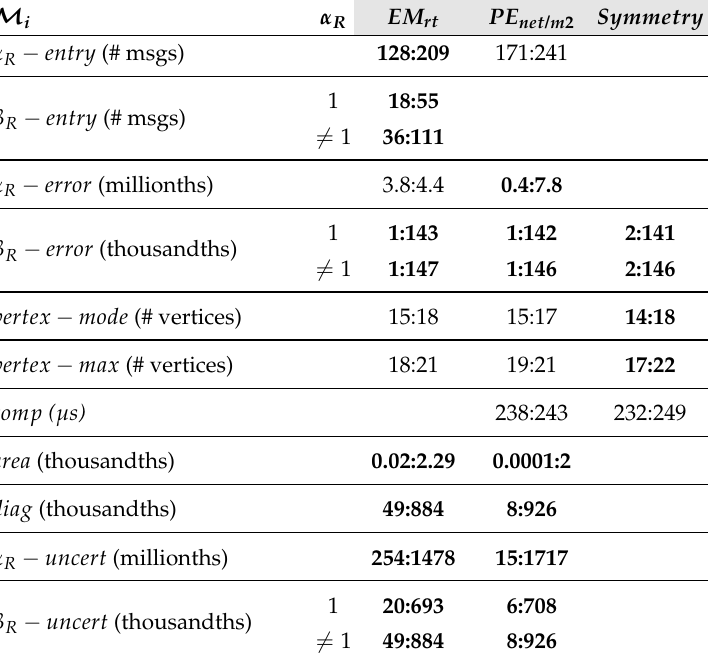
Table 4. Effects of the scenario on clock synchronization—delays.